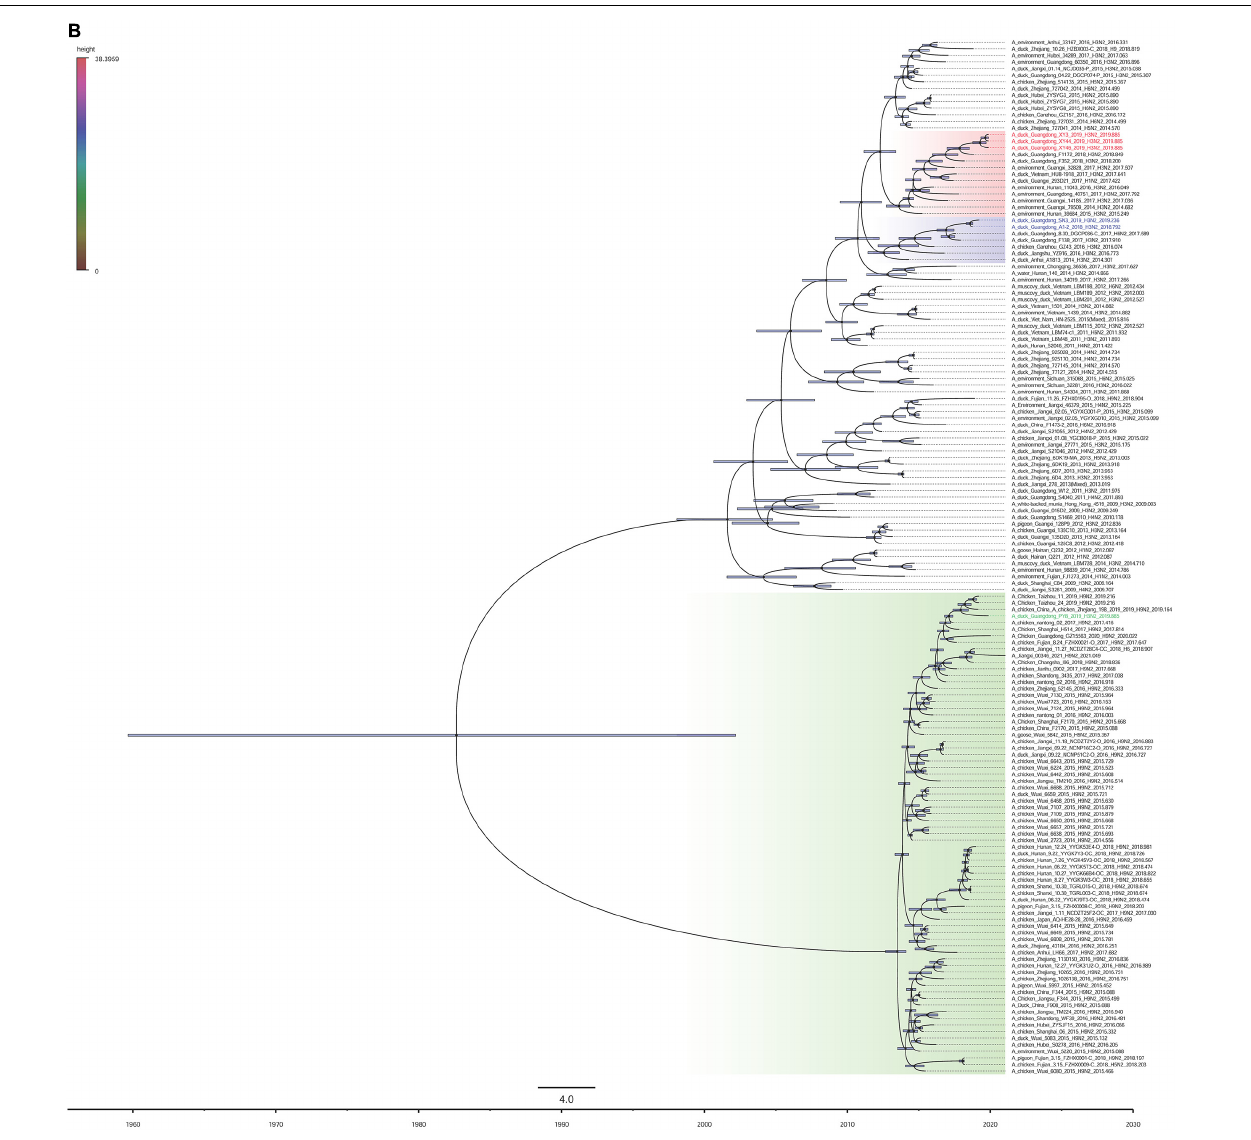
FIGURE 2 | Maximum clade credibility trees of the coding sequences of 2 segments. Node bars indicate the 95% highest posterior density (HPD) of node height. The influenza A virus strains isolated in this study are colored red, blue, and green. Each branch was colored by posterior probability. The segments shown are (A) hemagglutinin (HA); (B) neuraminidase